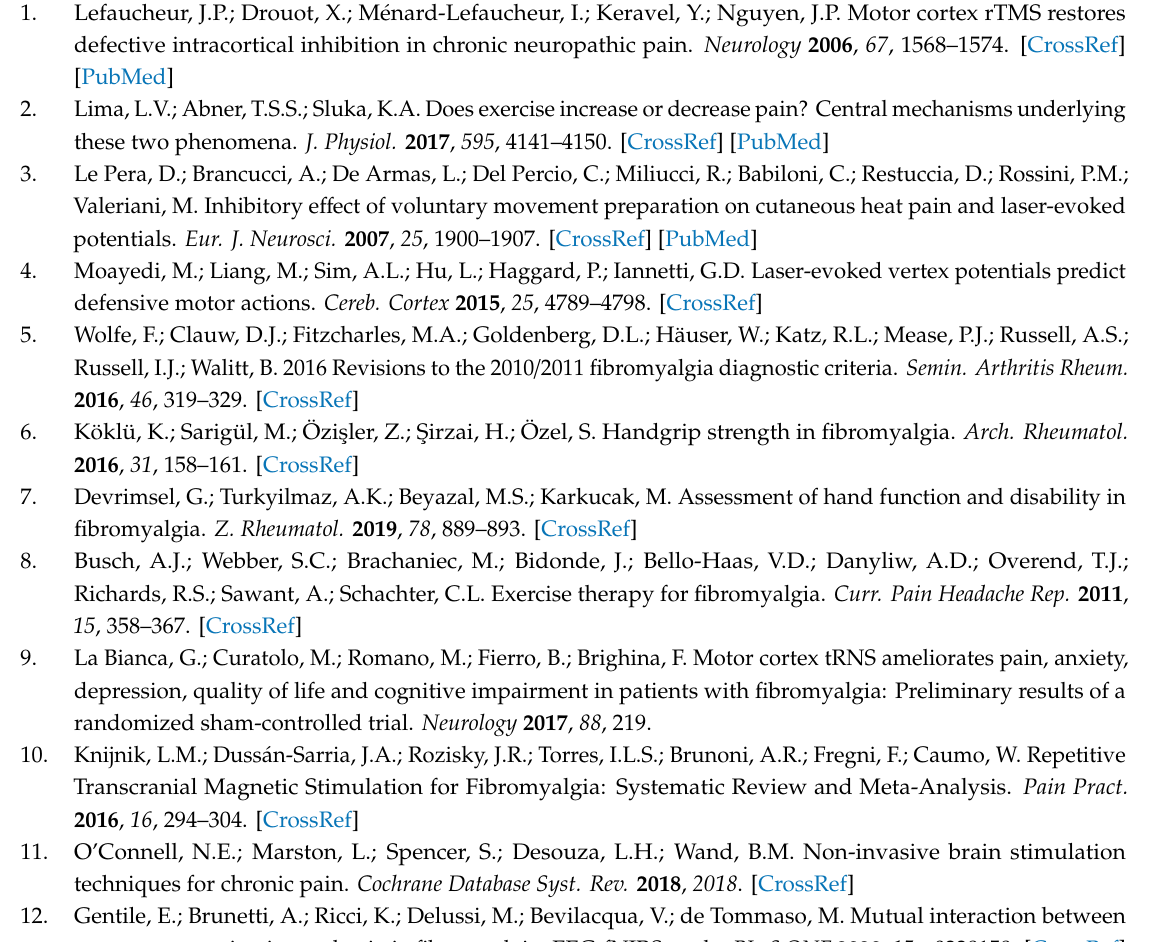
Table S1: Topographical coordinates of the relevant t -test ( p < 0.05) resulting from the comparisons between the sLORETA signal in the basal condition and the FFT task in control subjects (paired comparison); Table S2: Topographical coordinates of the relevant t -test ( p < 0.05) resulting from independent groups analysis of sLORETA changes between the basal condition and the FFT